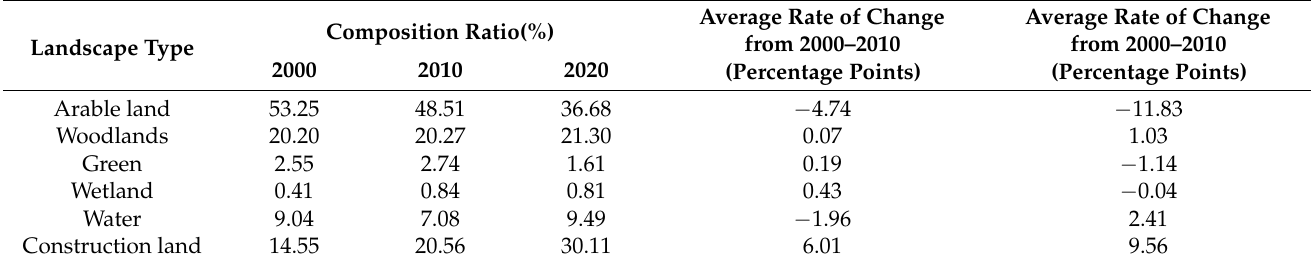
Table 5. Evolution of land use landscape composition in main districts from 2000 to 2020.